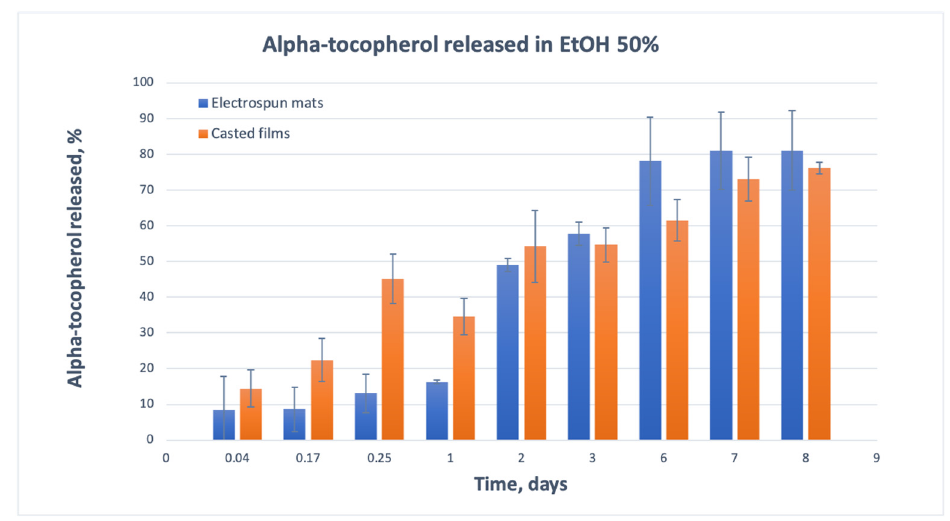
Figure 8. Release of alpha-tocopherol from electrospun sample impregnated for 2 h and from casted sample impregnated for 24 h, in EtOH 50% as a simulant, for a week at 40 °C.